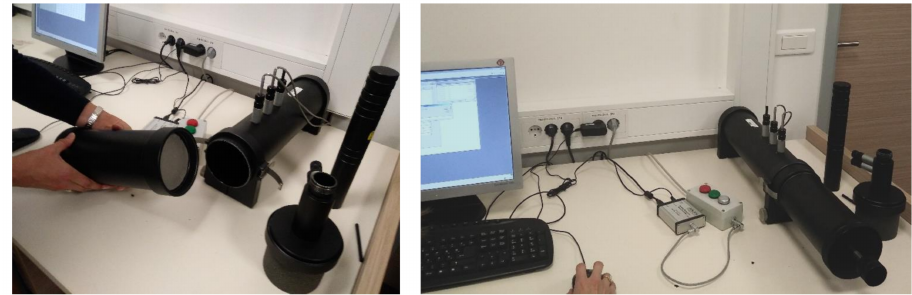
Figure 6. Open impedance tube with the inserted specimen ( left ) and assembled impedance tube ready to conduct the experiment ( right ).